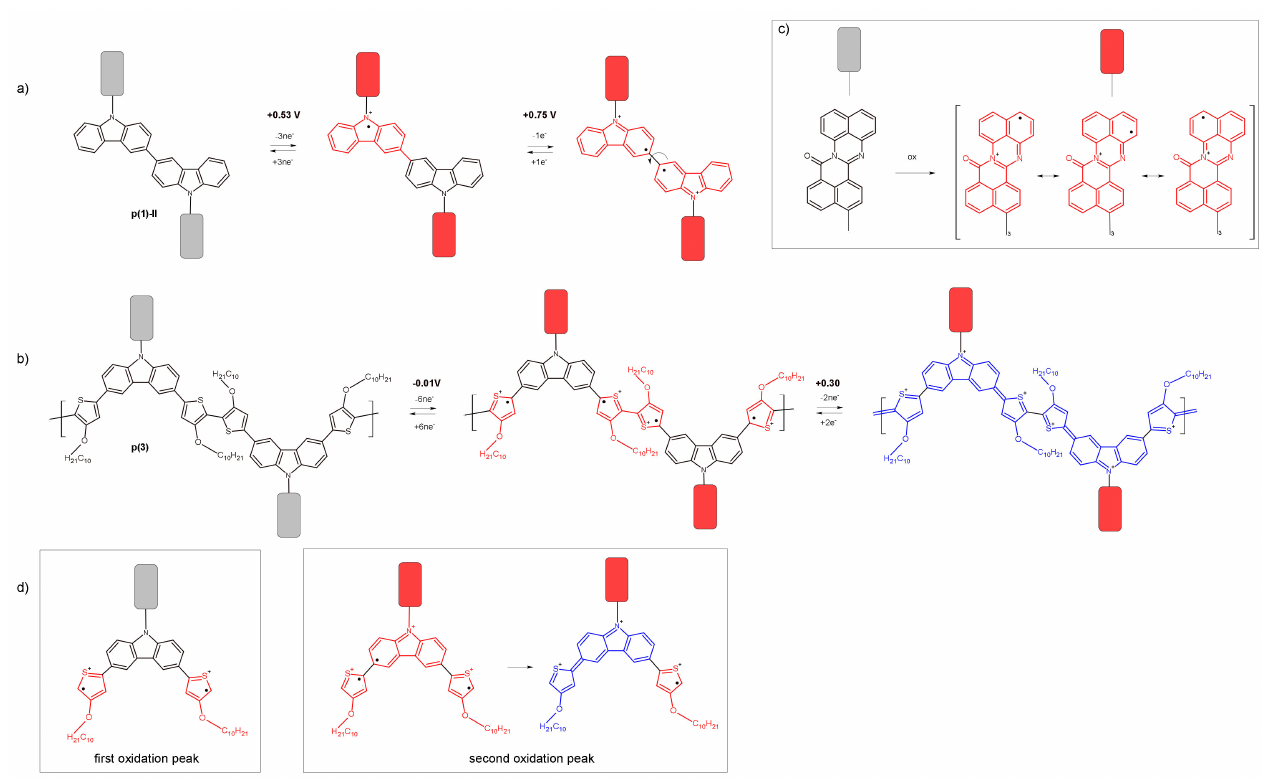
Scheme 3. Electrooxidation of one-dimensional π -conjugated p(1)-II ( a ) and p(3) ( b ); radical cation (polaronic) state ( red ); dication (bipolaronic) state ( blue ). Perimidine side-group marked as a rectangle shape: neutral ( grey ) and oxidized moiety ( red ) ( c ); transformation of 3 under the influence of potential at first and second oxidation peak ( d